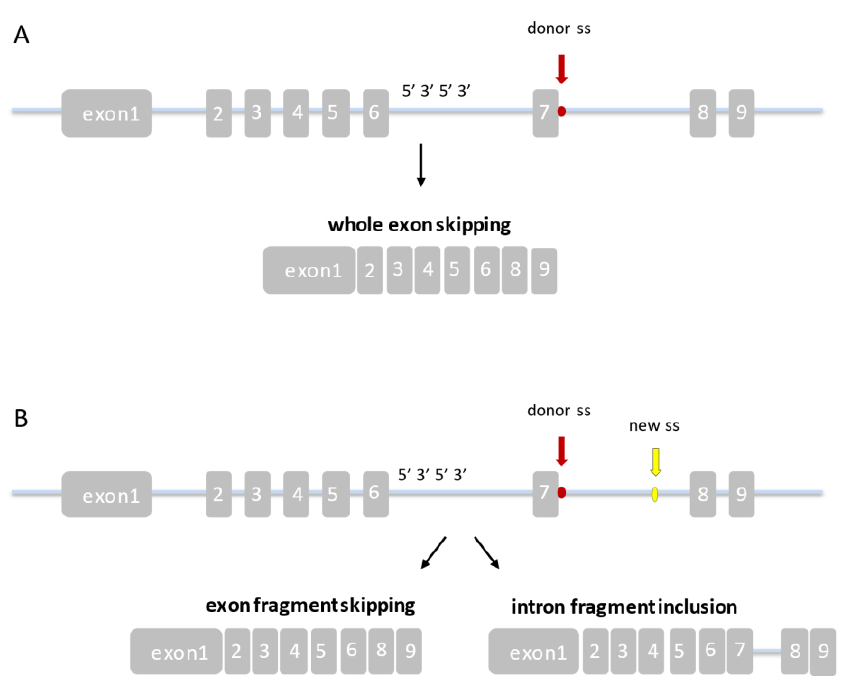
Figure 3. Results of automated DNA sequencing for CYP11A1 splice site mutation NM_000781.2 c.1236 + 5G > A (upper chromatogram) and missense mutation NM_000781.2 c.566C > T; p.(Ala189Val) (bottom chromatogram) .